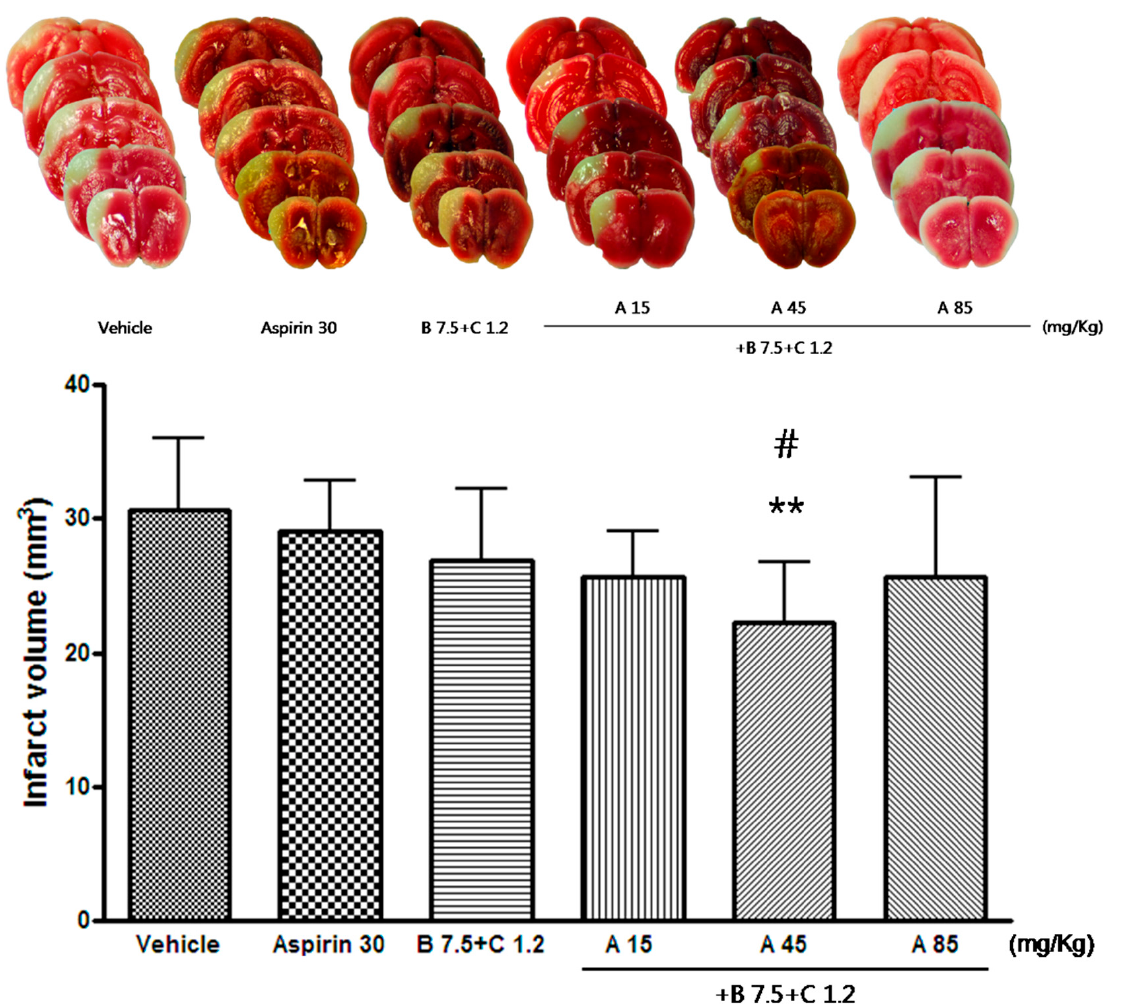
Figure 10. Effects of Sample A + B + C on ischemic brain injury after permanent middle cerebral artery occlusion (pMCAO). Infarct volume was measured 24 h after pMCAO. ( Upper ) Representa- tive photographs of infarcted brain slices from vehicle- and ‘drug A + B + C’-treated mice. ( Lower ) There was no significant among-group difference in the cortical infarct volume after 24 h ( n = 8–10 mice for each group). Data represent means ± standard deviation. A, Chunghyuldan; B, ethanol extract of Radix Salviae Miltiorrhizae and Radix Notoginseng; C, Borneolum Syntheticum.